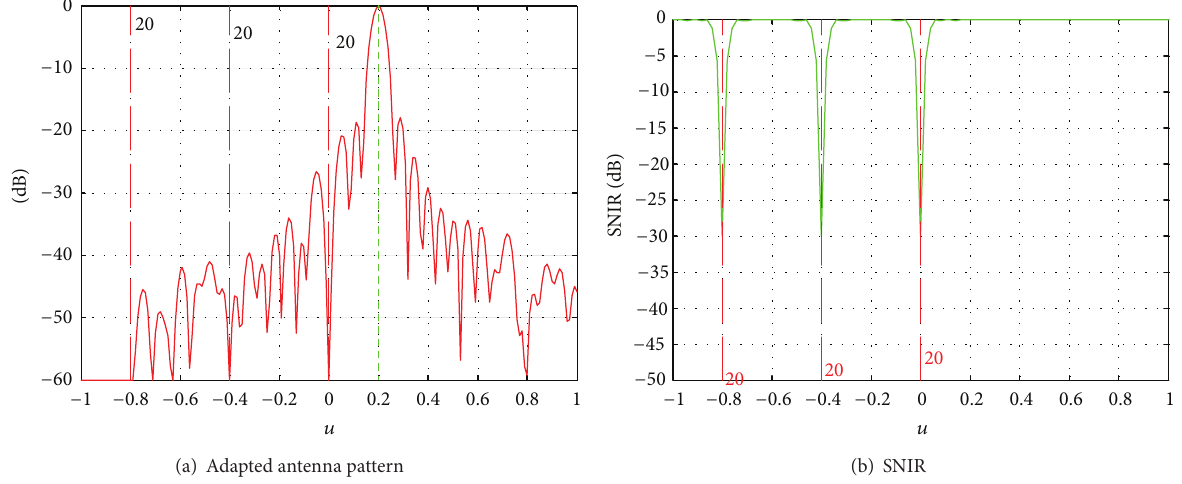
Figure 5: Antenna and normalized SNIR patterns for a three jammer configuration and generic